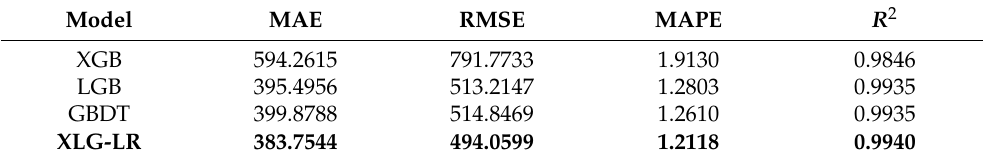
Table 4. Evaluation Index for Power Demand Forecasting of Each Model on a Weekly